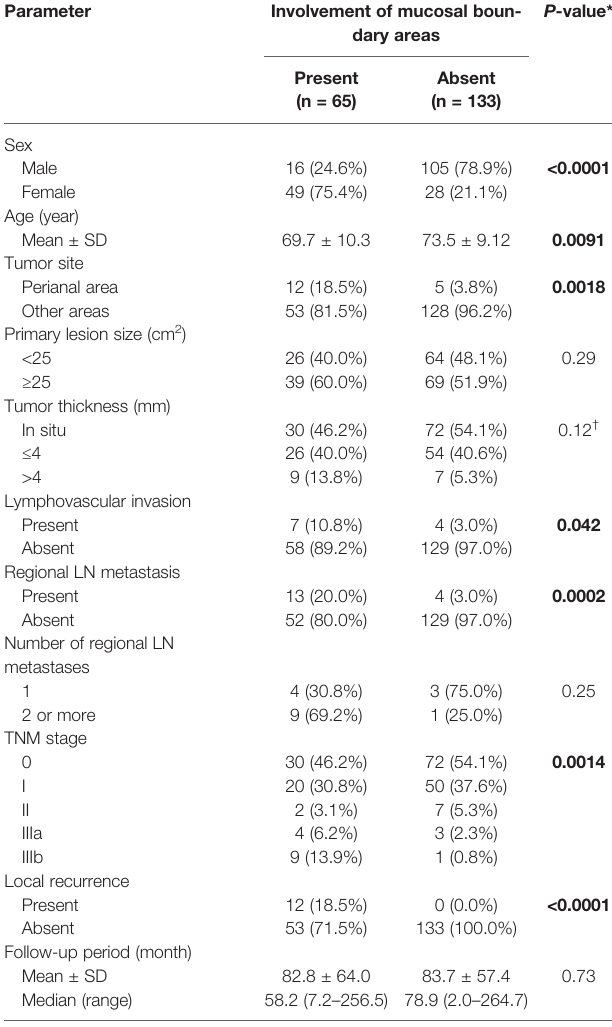
TABLE 2 | Demographics and clinical data of the 198 patients treated with curative surgery. Parameter Involvement of mucosal boun-